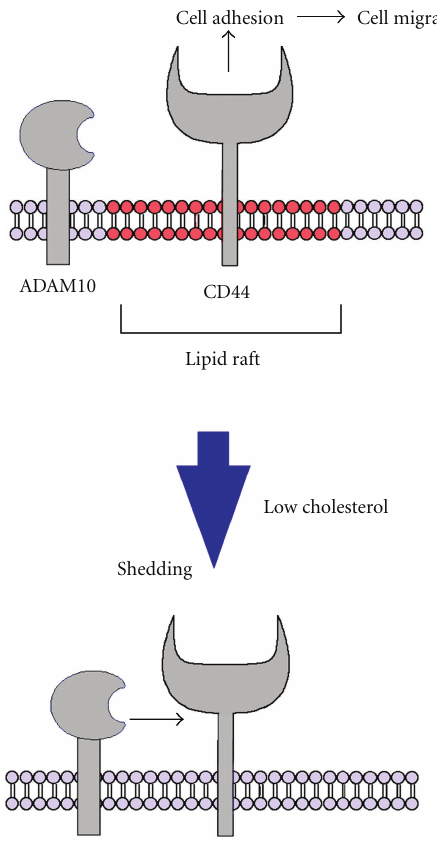
Figure 2: A putative model of the lipid-raft-related cancer cell adhesion and